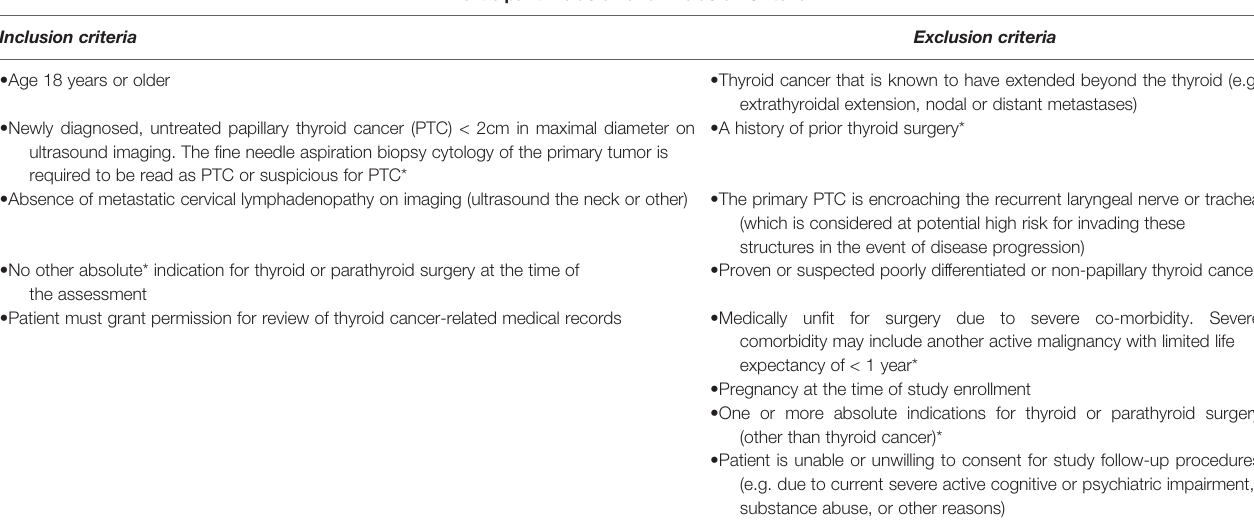
TABLE 1 | Eligibility criteria.